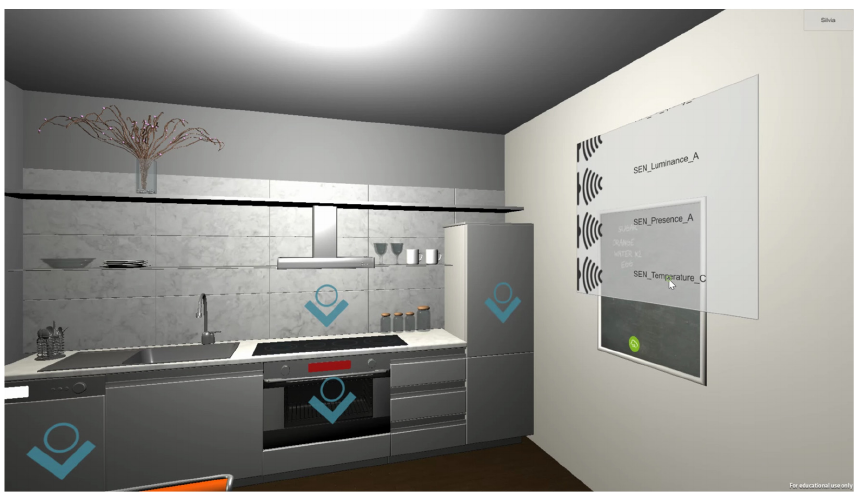
Figure 8. A snapshot of RecAAL: The list of sensors selected during the reconfiguration process is shown on the blackboard in the 3D environment.